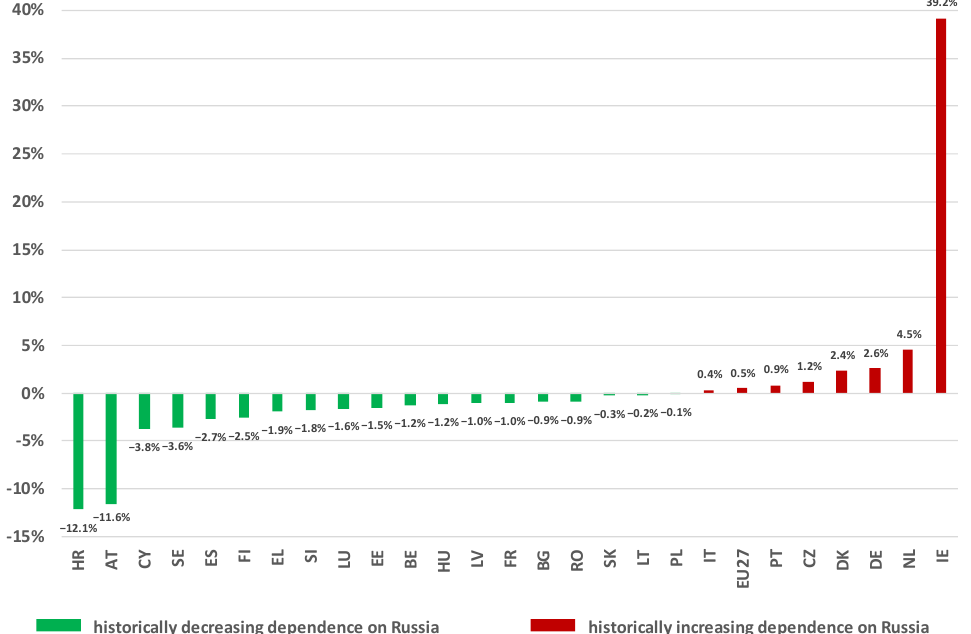
Figure 2. Figure 2. DRTs.